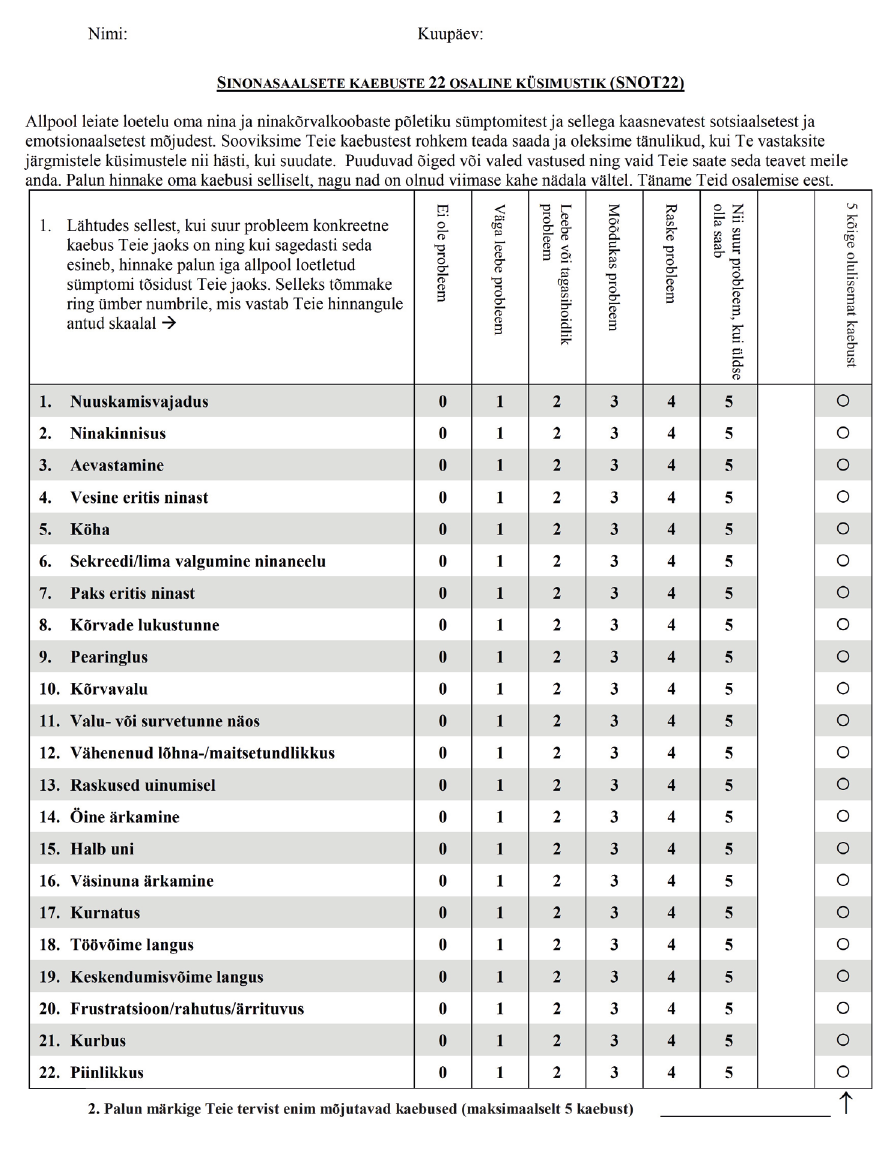
Figure 1. Estonian version of the